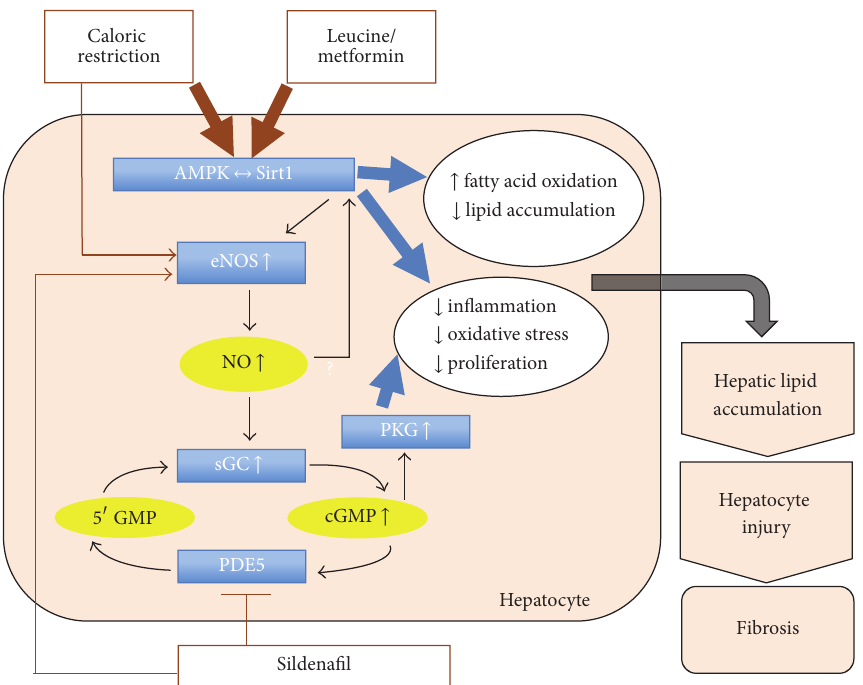
Figure 12: Proposed model of the interaction of leucine, metformin, and sildenafil on the AMPK/Sirt1/eNOS network. AMPK, Sirt1, and eNOS are nutrient sensors responsive to caloric restriction, regulating energy metabolism in an interacting network. In addition, they prevent inflammation and reduce oxidative stress and proliferation, the key factors for the progression of NAFLD to NASH. Leucine and metformin synergistically activate the AMPK/Sirt1 pathway while sildenafil contributes to further stimulation through activation of eNOS. Moreover, sildenafil’s inhibition of PDE5 results in concomitant activation of the cGMP-dependent protein kinases (PKGs). These integrated effects result in reduction of hepatic lipid accumulation, hepatic inflammation and injury, and subsequently reduction of